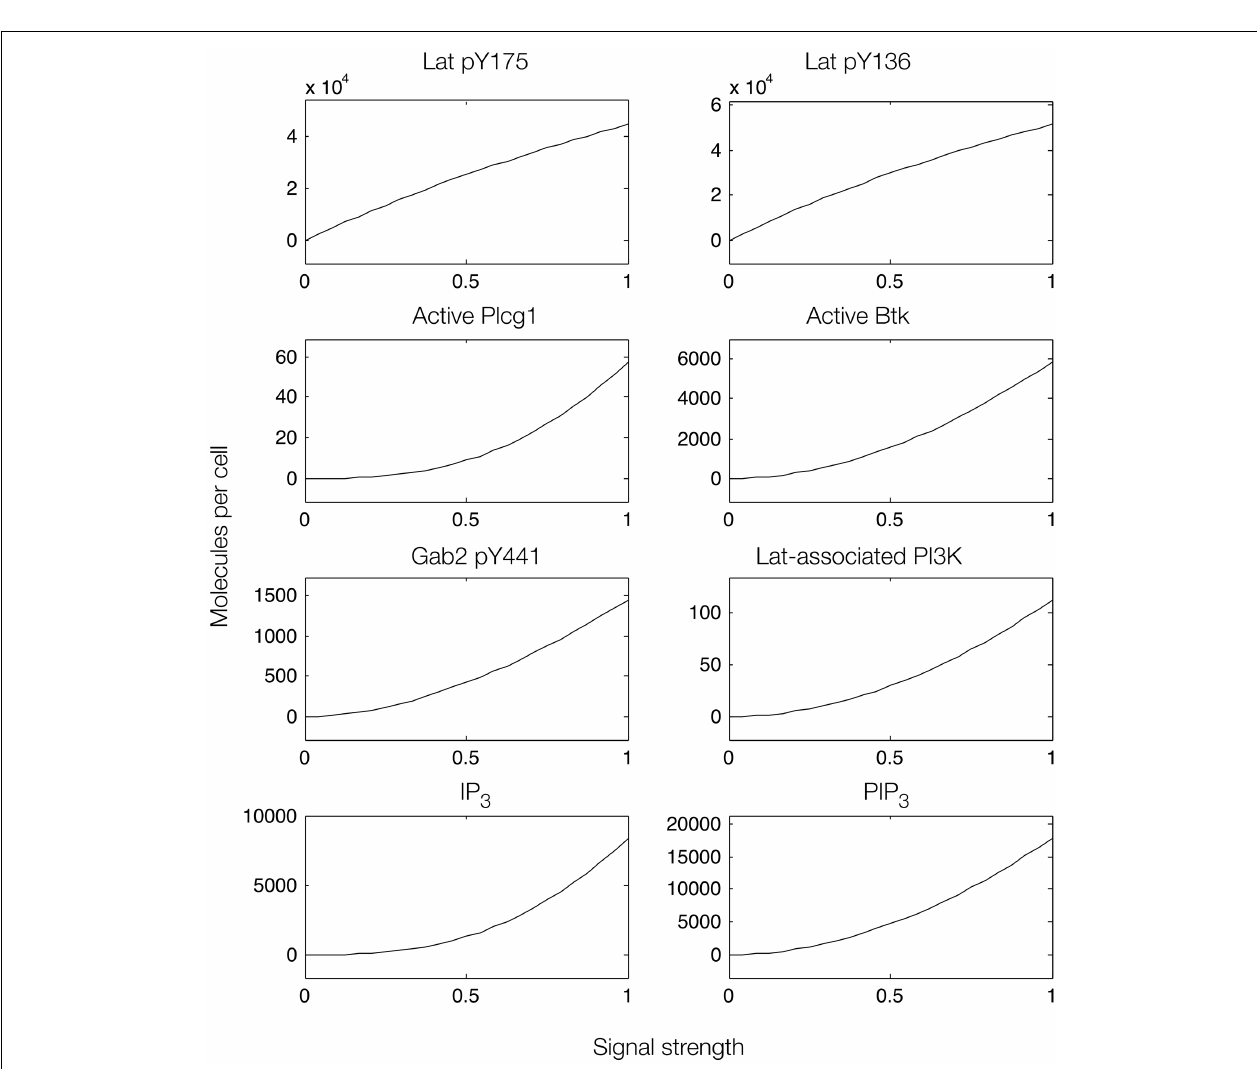
Lat (top panels) results from different affinities of the binding partners that interact with each site. Active Plcg1 is taken to be Plcg1 that is both recruited to Lat and phosphorylated, and active Btk is taken to be Btk recruited to PIP 3